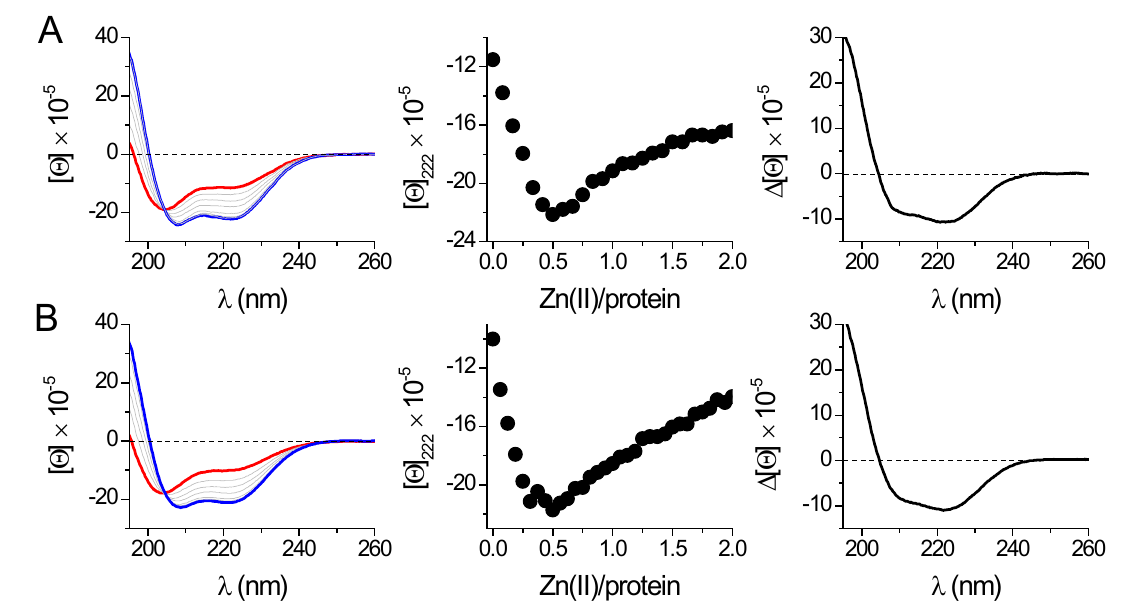
Figure 4. Zn(II) binding to 183-amino-acid-long proteins Hs Hk183 ( A ) and Hs Hk183 T690E ( B ) was monitored spectropolarimetrically in 20 mM Tris-HCl buffer, pH 7.4, 100 mM NaF. The left panel shows spectra of the apo-form (red line) titrated with Zn(II); the complex at a 0.5 molar ratio is shown as a blue line. The middle panel shows ellipticity changes at 222 nm in the Zn(II)/protein molar ratio function. The right panel presents differential CD spectra for Hs Hk183 protein fragments obtained by subtraction of the apo-form spectra from the spectra of complexes at a 0.5 molar ratio. [Θ] corresponds to molar ellipticity in deg × cm 2 × dmol − 1 .